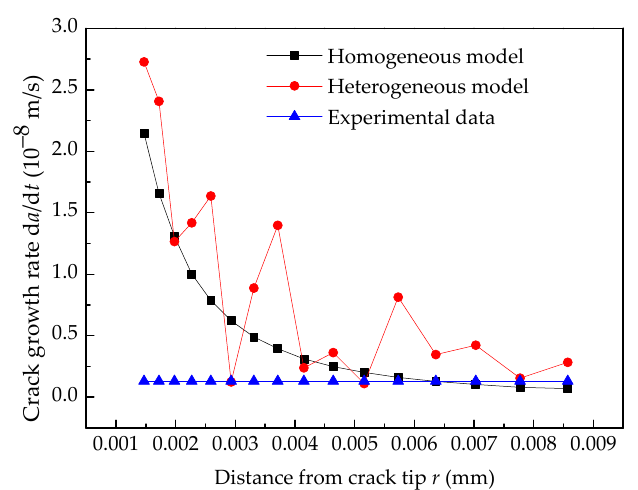
Figure 11. Comparison of EAC growth rate with experimental data.